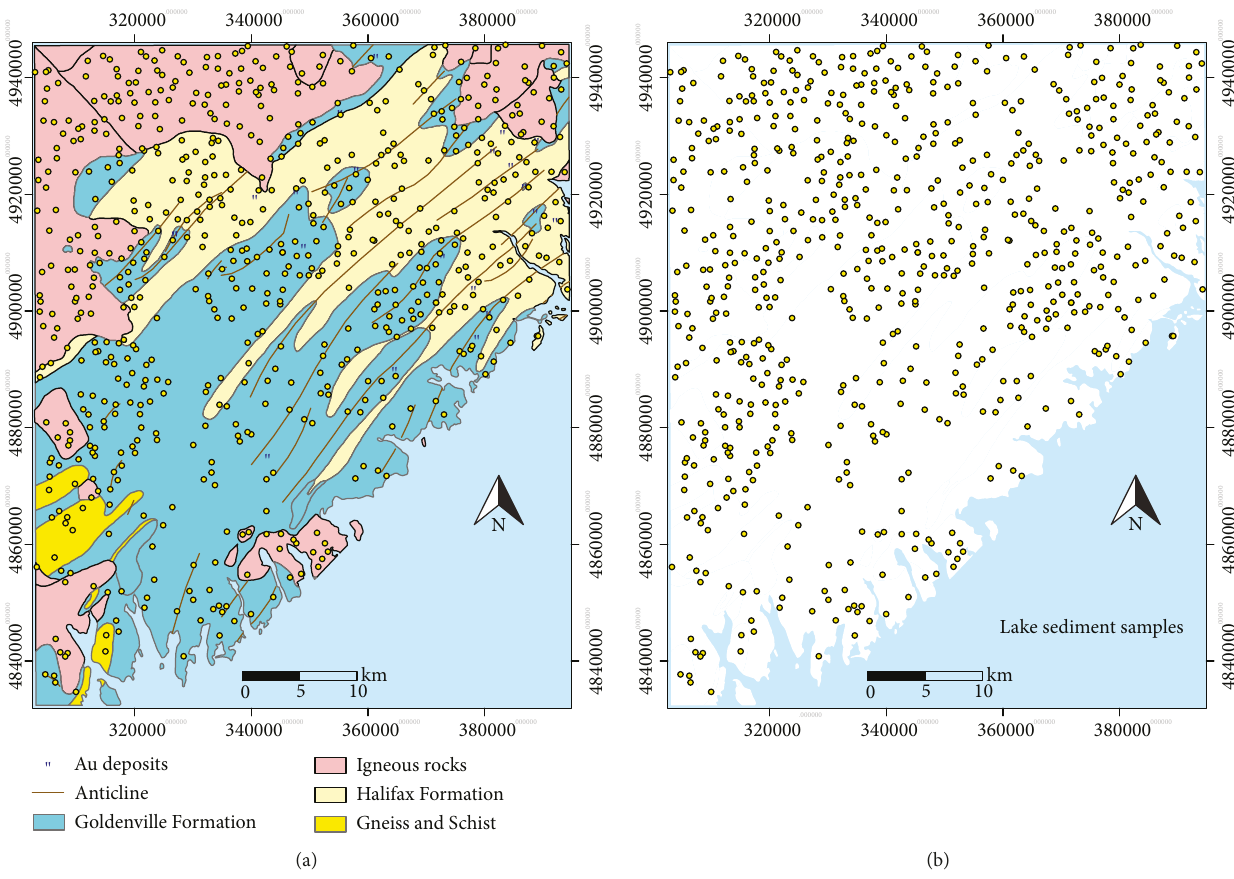
Figure 1: (a) The simpli fi ed geology and distribution of known gold deposits (black dots) in southern Nova Scotia. Solid black lines are traces of Devonian anticlines. (b) The locations of 671 lake sediment samples in the area (source: [8], Figure